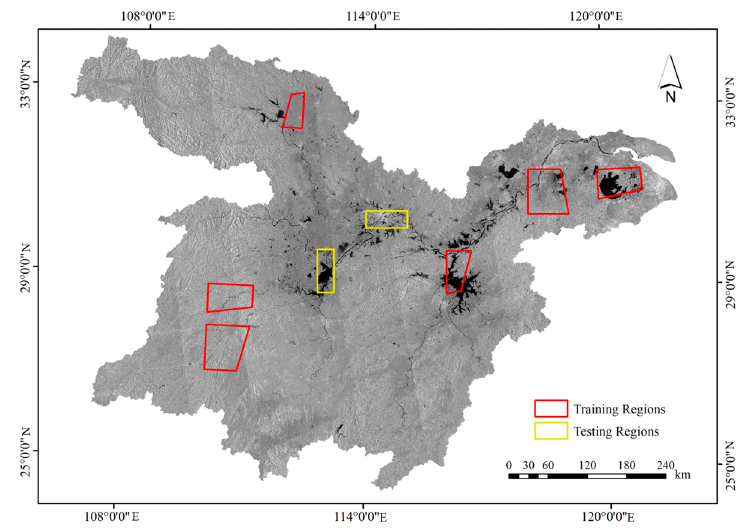
Figure 4. Training regions and testing regions in the study area.